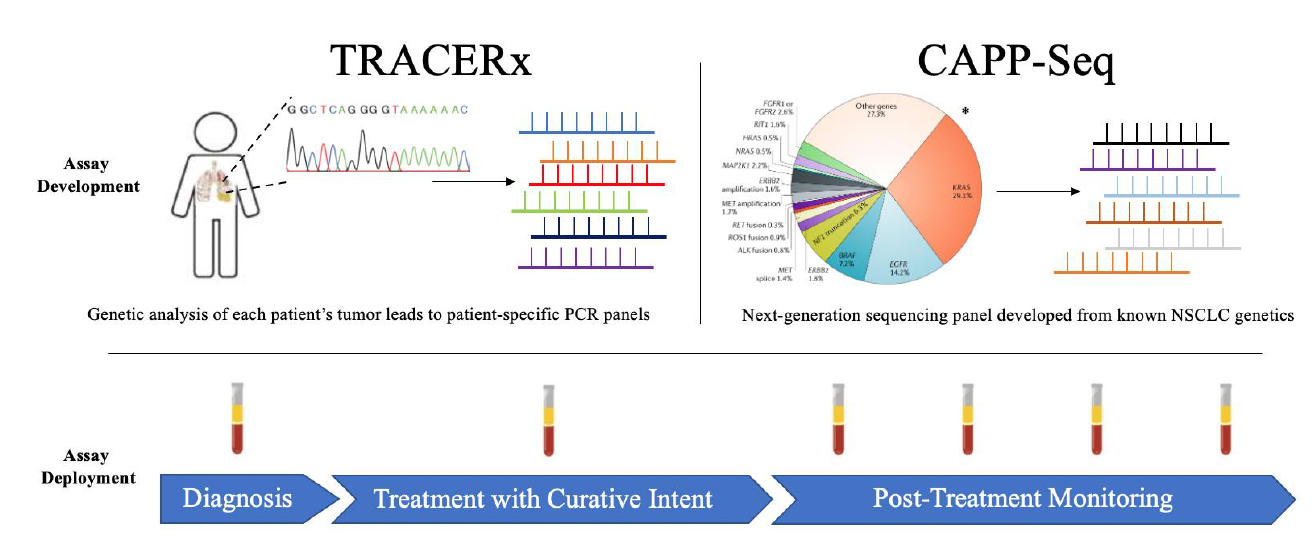
Figure 1. The unique assay development of TRACERx and CAPP-Seq highlight their several differences which lay the foundation for their respective strengths and weakness. However, the deployment of each assay consisted of plasma monitoring from diagnosis to the post- treatment period. *Figure adopted from Skoulidis et al. [57].